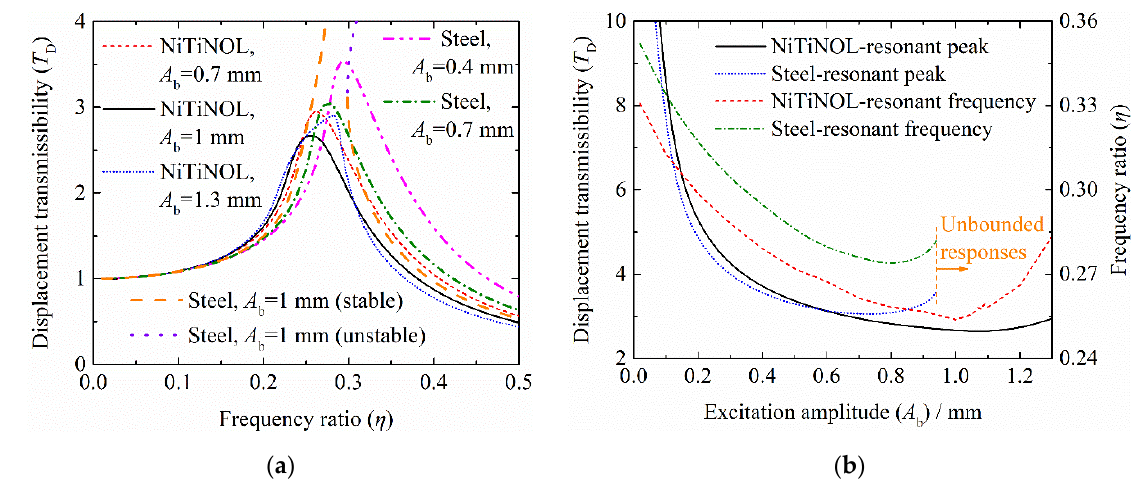
Figure 6. The frequency responses of the isolators. ( a ) The displacement transmissibility with different excitation amplitudes, and ( b ) the relationships among the peak transmissibility, the resonant frequency, and the excitation amplitude.